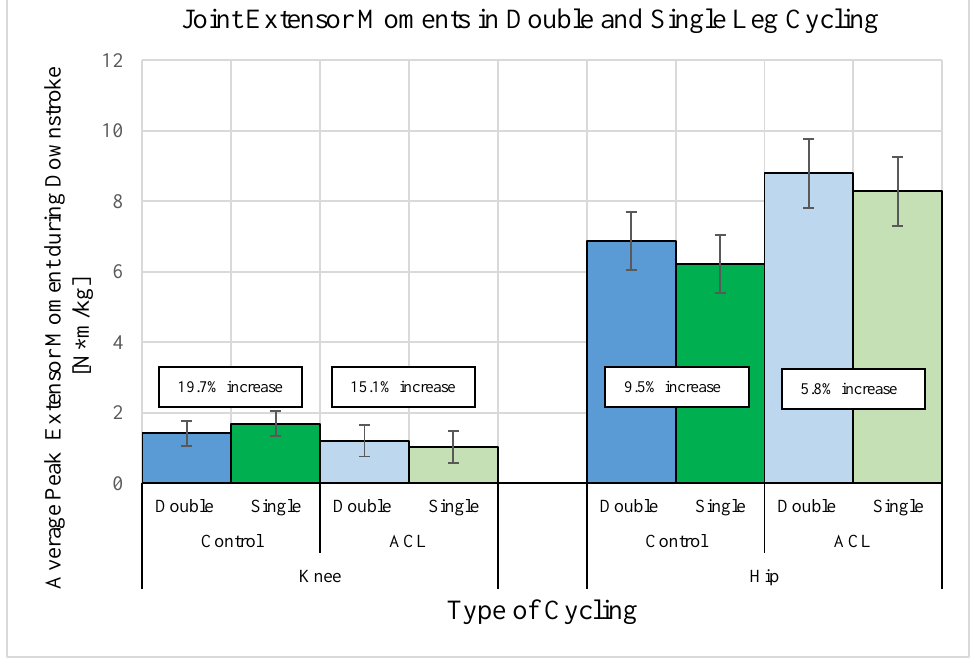
Figure 5. Average peak joint extensor moments in the downstroke (no significance was found; p < 0.05).